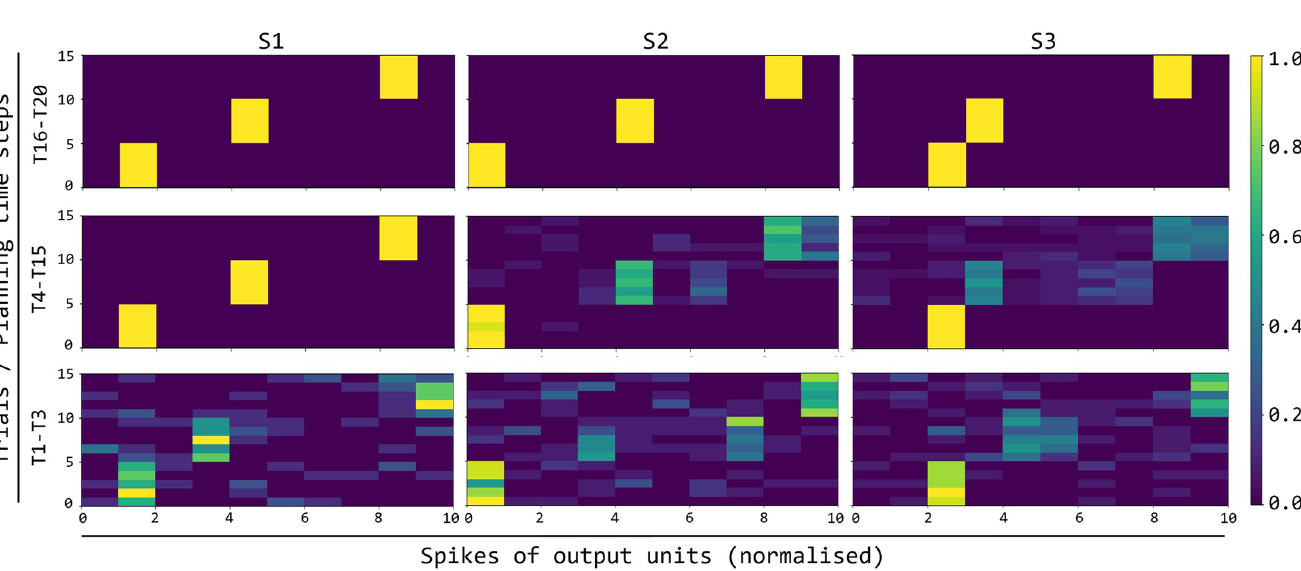
PLOS Computational Biology | https://doi.org/10.1371/journal.pcbi.1007579 December 8,